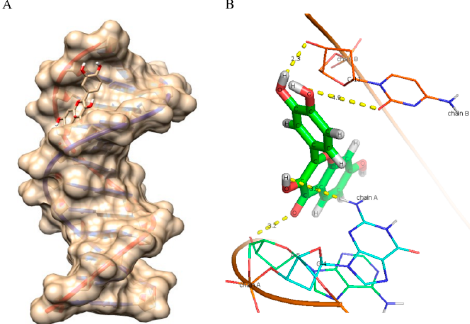
Figure 7 . Molecular docked structure of fisetin with B-DNA. ( A ) Surface view interaction of fisetin with B-DNA; ( B ) Hydrogen bonding interactions (4) and distance in Å of fisetin with dodecamer duplex of sequence (CGCGAATTCGCG) 2 (PDB ID: 1BNA).